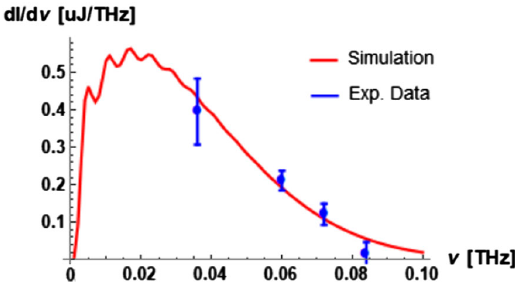
FIG. 8. CTR spectrum, comparison between simulations and experimental data for a bunch length of approximately 3 (cid:2) 0 . 5 ps. Oscillations at low frequencies are due to interference effects related to the finite-size of the radiator [42]. Electron beam parameters (per single bunch): 215 MeV, 3 ps, 40 pC.